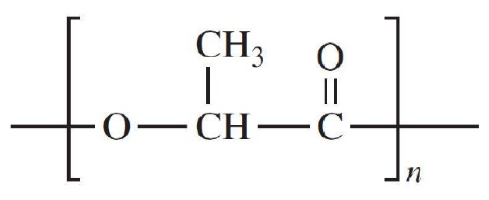
Figure 1. Chemical structure of PLA .